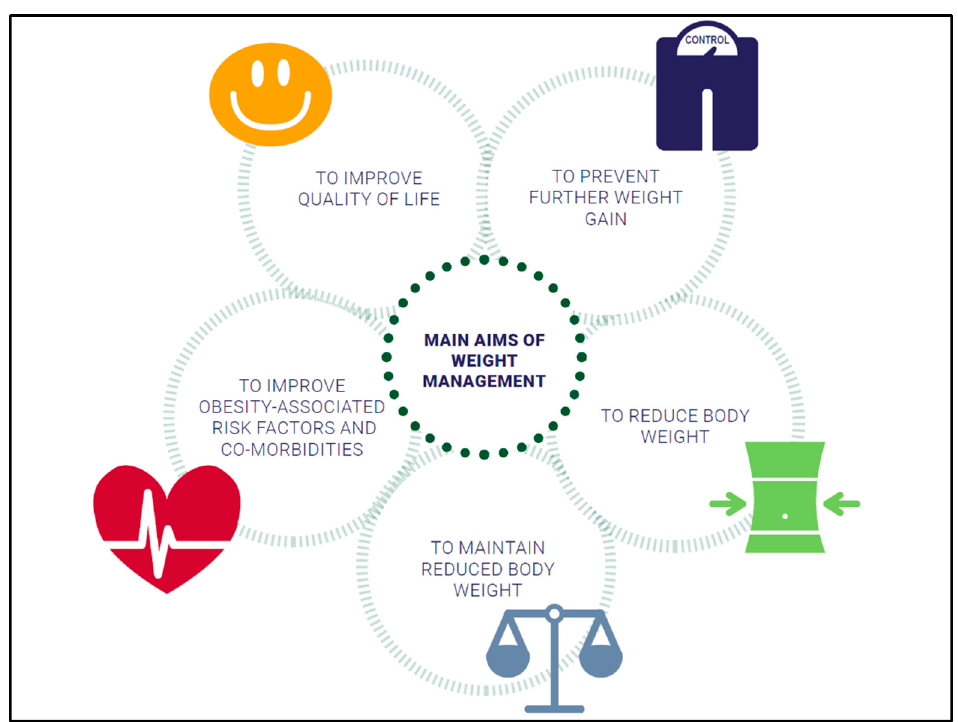
Figure 1. Treatment approaches.